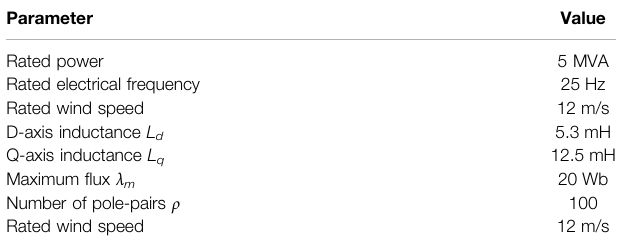
TABLE 1 | Parameters of the PMSG.